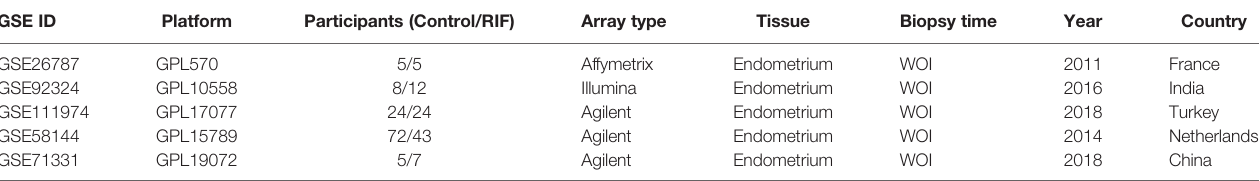
TABLE 1 | Characteristics of the included microarray datasets. GSE